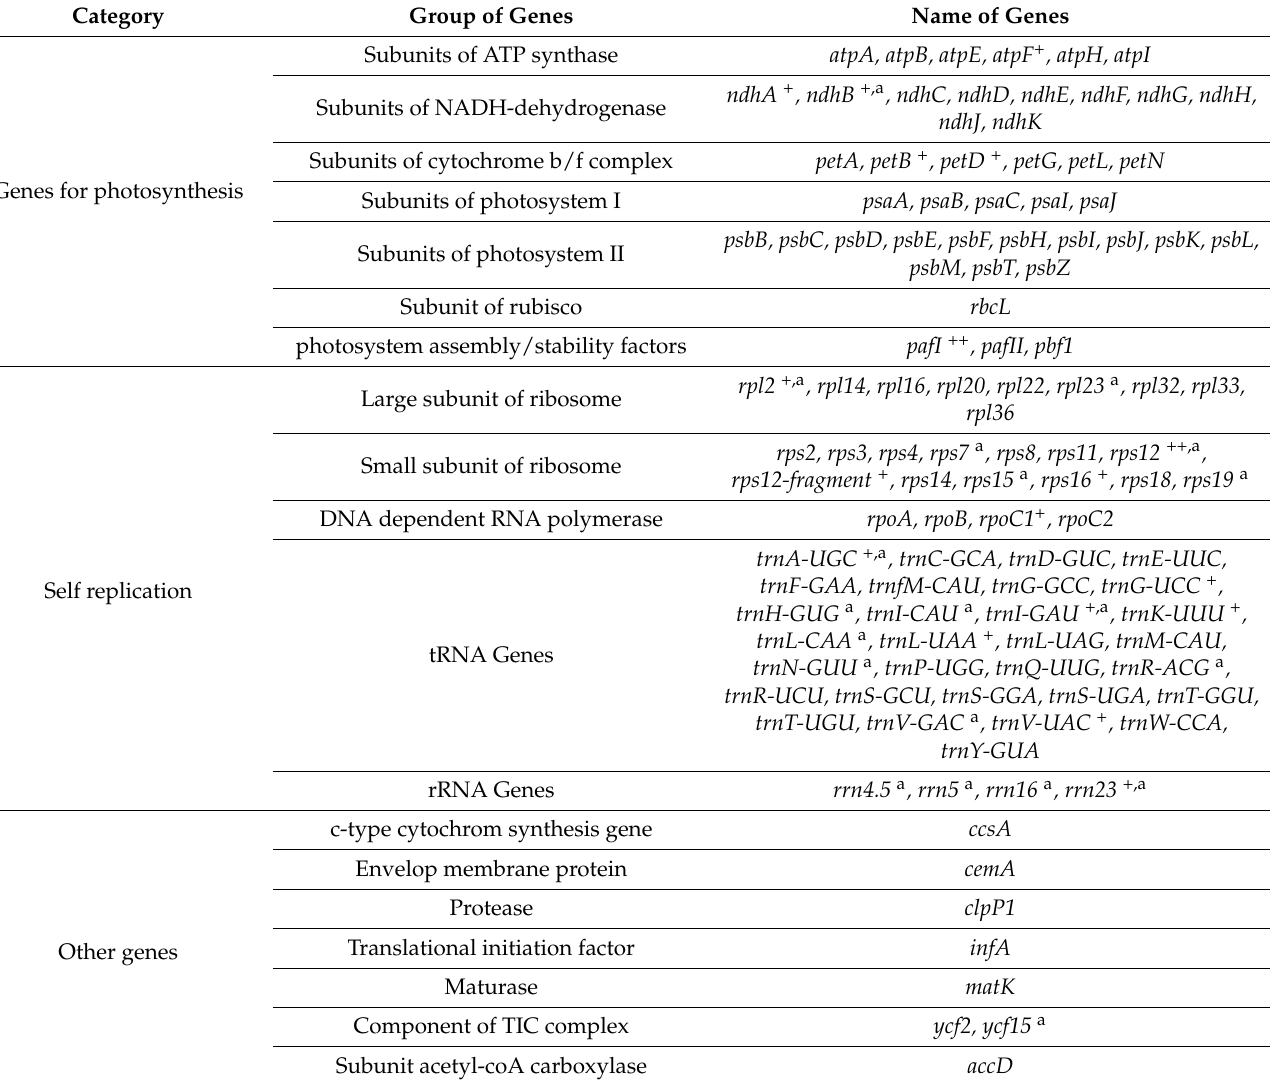
Table 1. Genes present in the cp genome of D. farinosus .